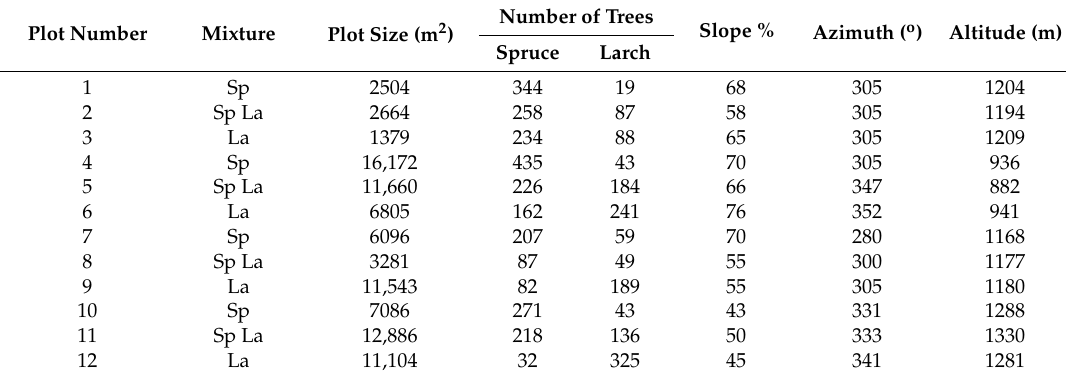
Table 1. Plot size and some site descriptors: Sp indicates the spruce plots, Sp La the mixed spruce and larch plots, and La the larch plots.